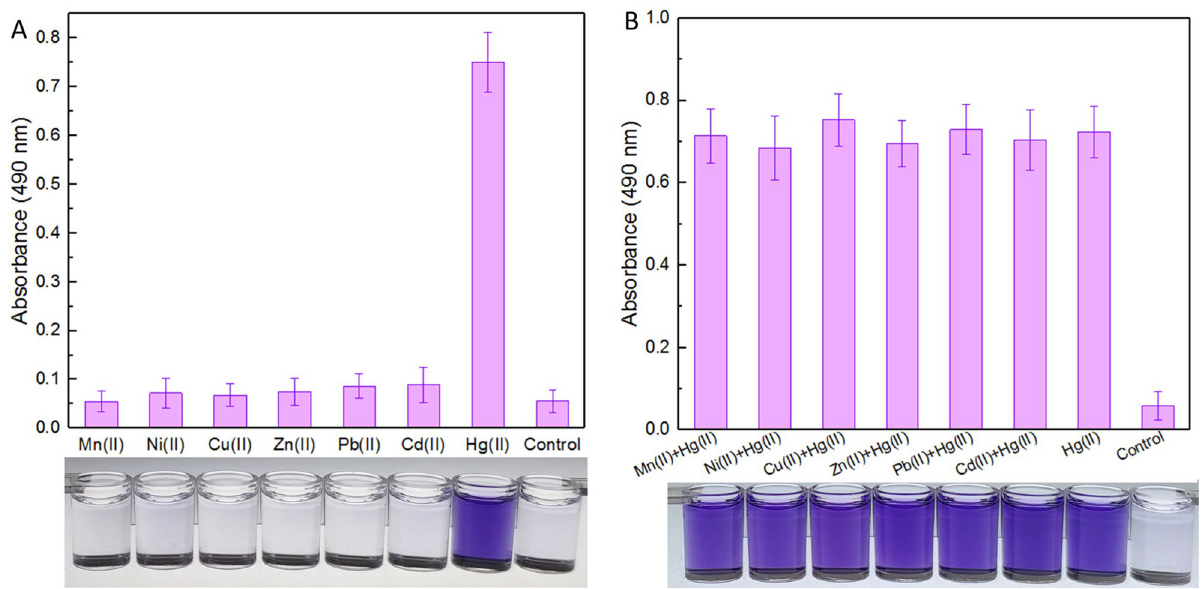
Figure 3. The biodetection selectivity of engineered whole-cell Hg(II) biosensor. Biosensor cells in the exponential growth phase were exposed to 8 μM of various metal ions alone ( A ) or in combination ( B ) at 37 °C for 12 h. The control groups were not supplemented with metal ions. The butanol phases containing violacein were prepared and read at 490 nm in a microplate reader. The photo shown at the bottom is representative of three independent experiments with similar results. The absorbance values of pigment were normalized to bacterial cell density at 600 nm. The results are shown as the mean of three independent assays ± the standard